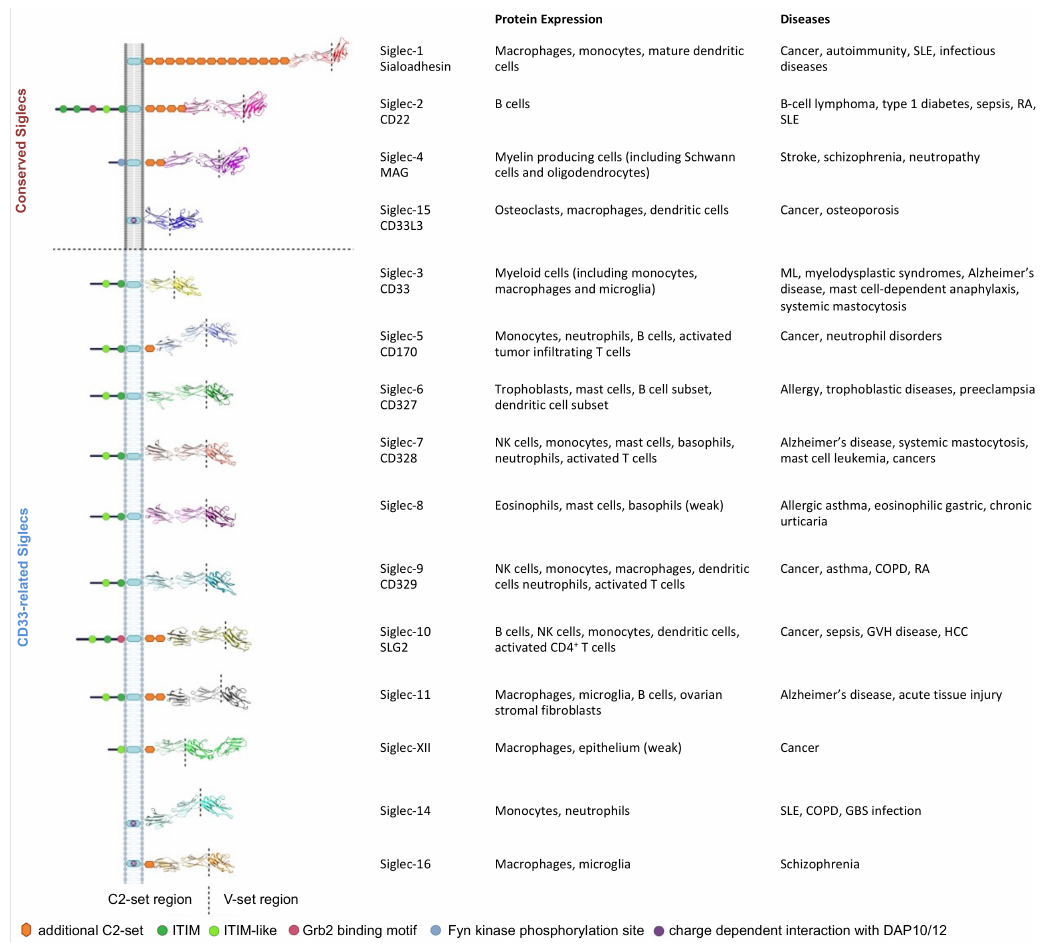
Figure 1. Human sialic-acid binding Siglec family members associated with various diseases. COPD: chronic